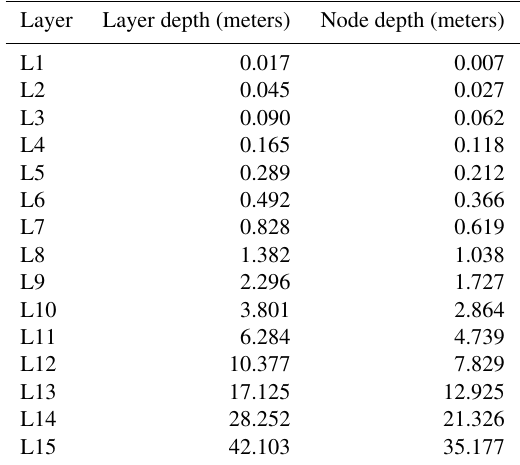
Table 1. Soil layers and node depths in CLM4. The node depth, which indicates the depth where the thermal properties are defined for soil layers (Oleson et al., 2010), does not necessarily coincide with the center of the layer